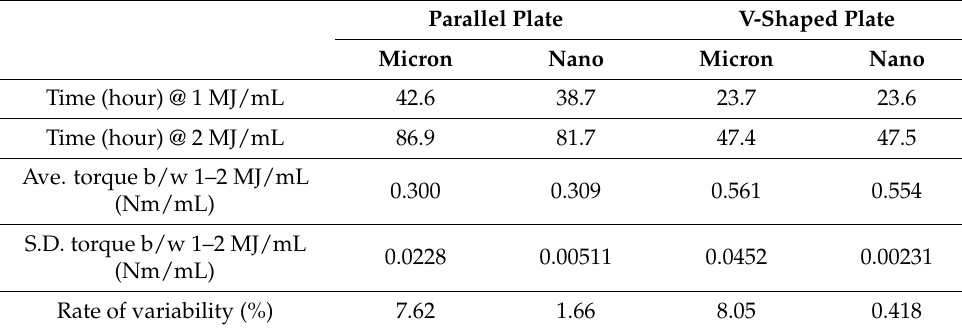
Table 5. Summary of the long-term